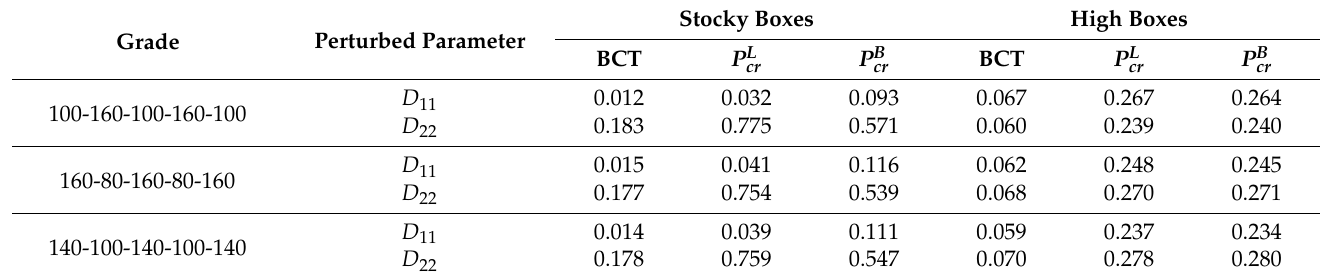
Table 3. Sensitivity of BCT and P cr regarding the D 11 and D 22 perturbation of a BC corrugated cardboard.